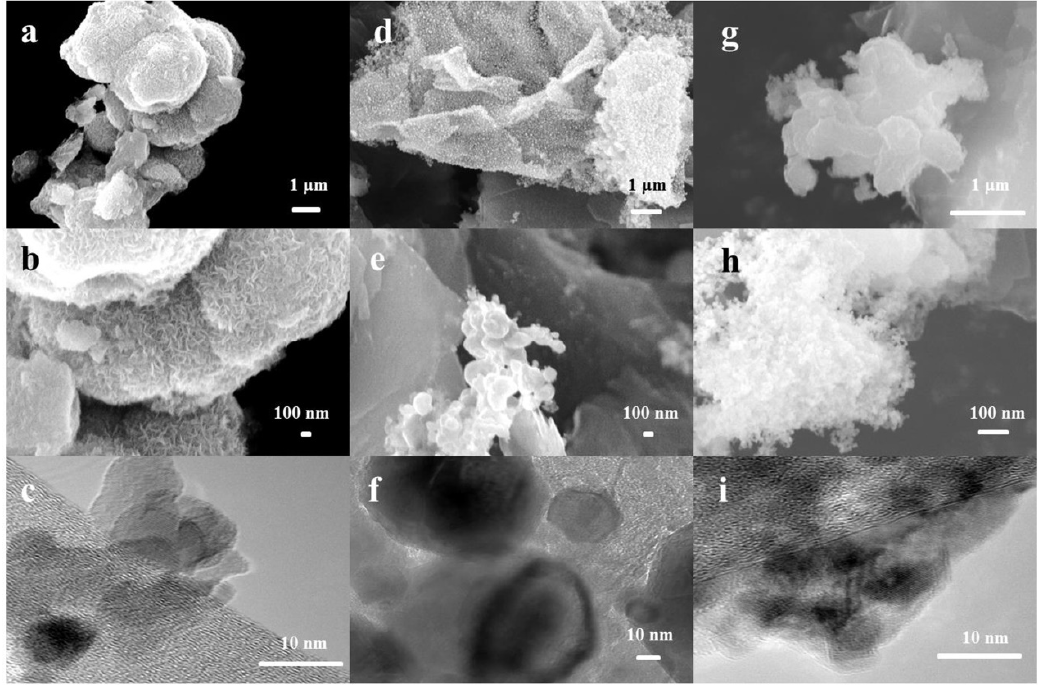
Figure 2. SEM images of ( a , b ) NiO x @GR-A2, ( d , e ) NiO x @GR-B2, and ( g , h ) NiO x @GR-C2 at different magnifications. TEM images of ( c ) NiO x @GR-A2, ( f ) NiO x @GR-B2, and ( i ) NiO x @GR-C2.